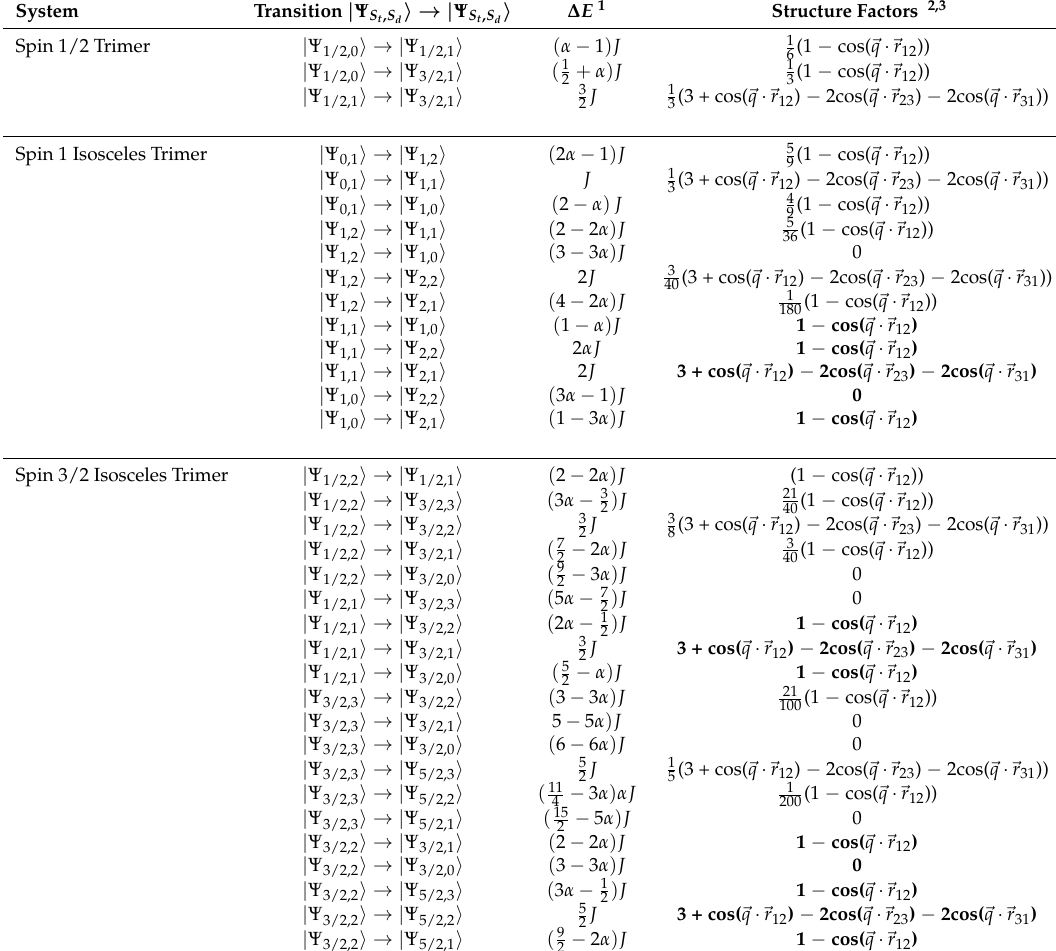
Table 2. Inelastic neutron scattering (INS) energy excitations and structure factors.